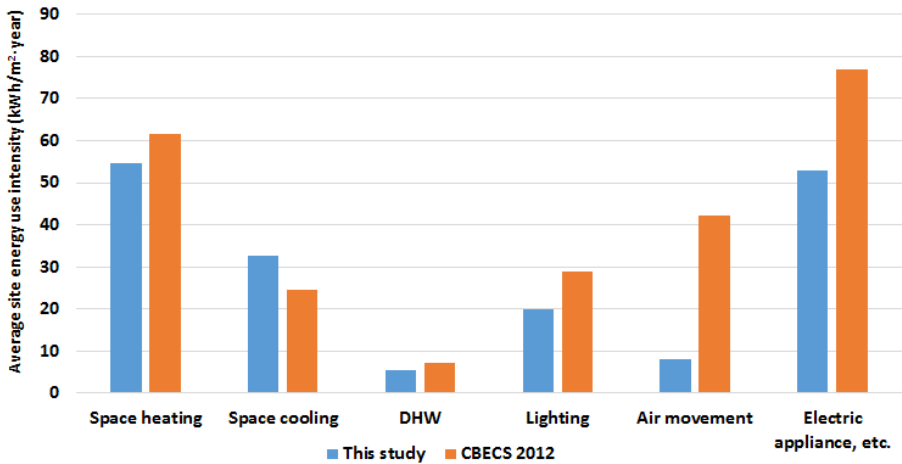
Figure 4. Magnitudes of average site end-use EUIs in this study and CBECS 2012.